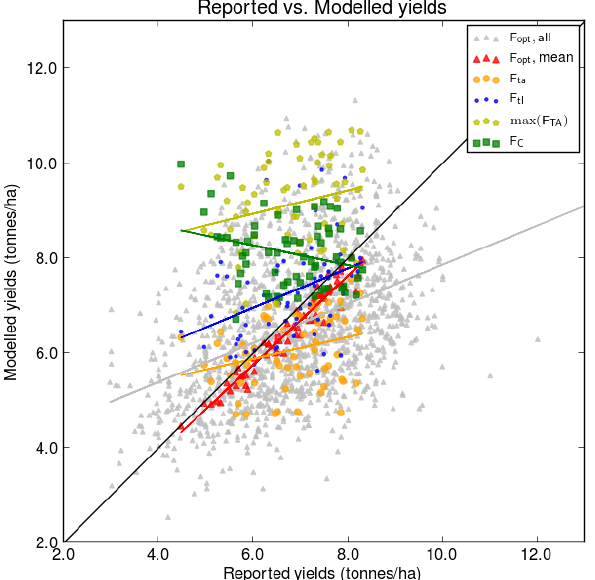
Figure 7. Reported vs. modelled yields for the 65 regions used in this study. Grey triangles represent all available years for each region, with the fertiliser management that gave the best agree- ment with data for each region ( F opt ( T , A ) , all); the red markers are their means. Dark green markers show the mean for each re- gion with the C-only version of the model ( F C ), pale green repre- sents the management that gave the maximum yields for each region (max( F T , A )). Orange markers show the result from using a mean N management over the region, blue represents simulations using the same timing for each region but with a spatially explicit data set of N application (Elliott et al., 2014) ( F t , I ). Lines are fitted linear re- gressions, see Table 5 for details. The number of years included for each region is listed in Table